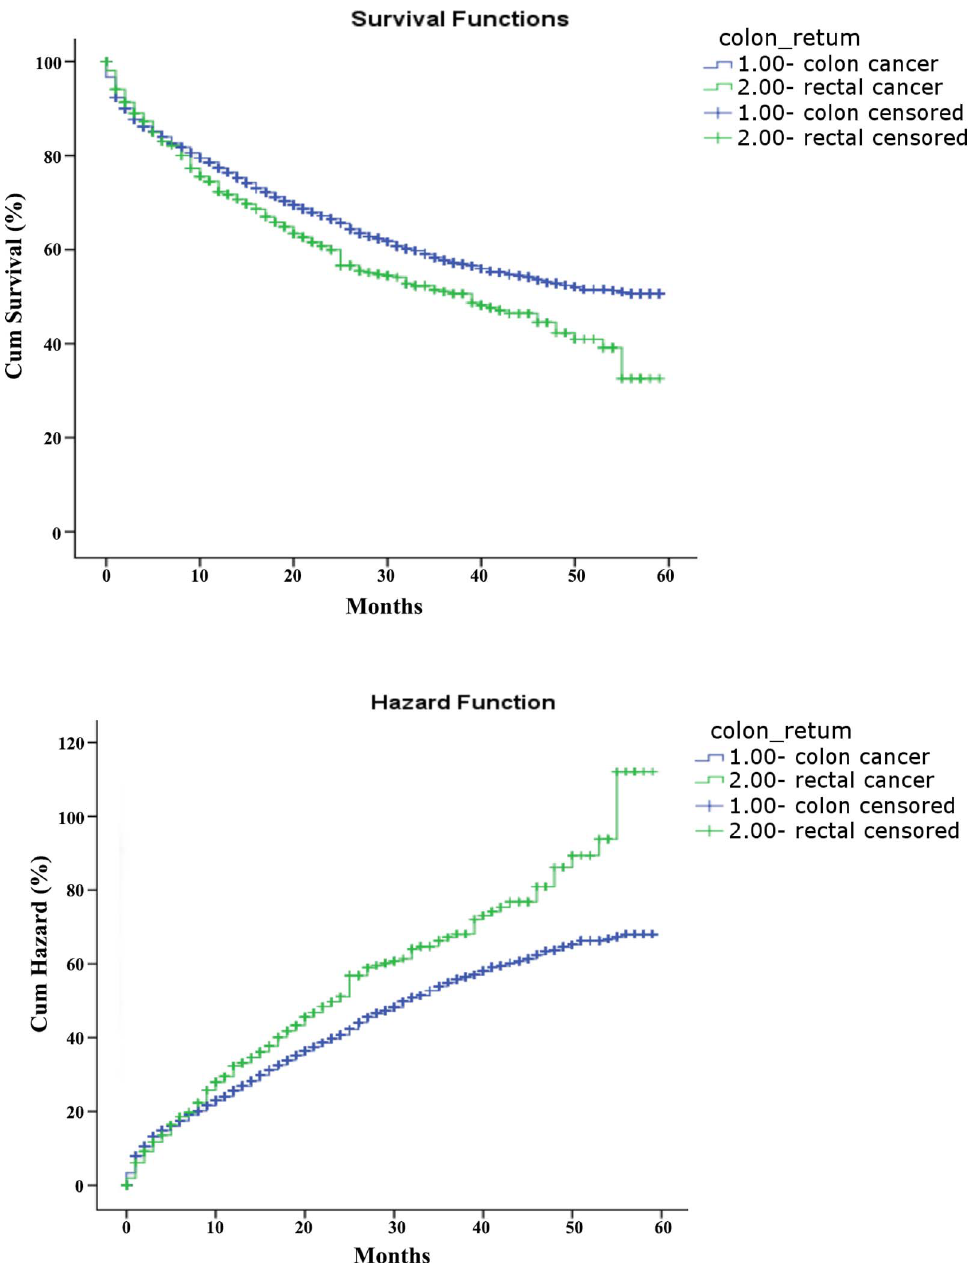
Figure 1. Survival and cumulative hazard for stage IIB colon and rectal cancer patients (1, colon cancer; 2, rectal cancer).